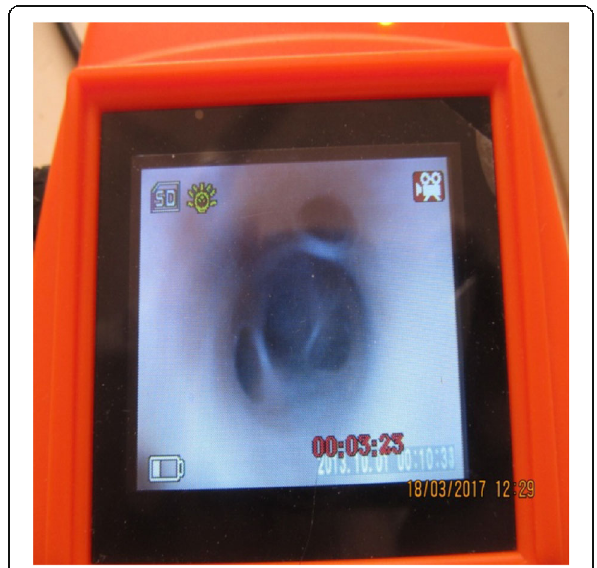
Fig. 4 Endoscopic visualization of one of the tracheal bifurcations showing